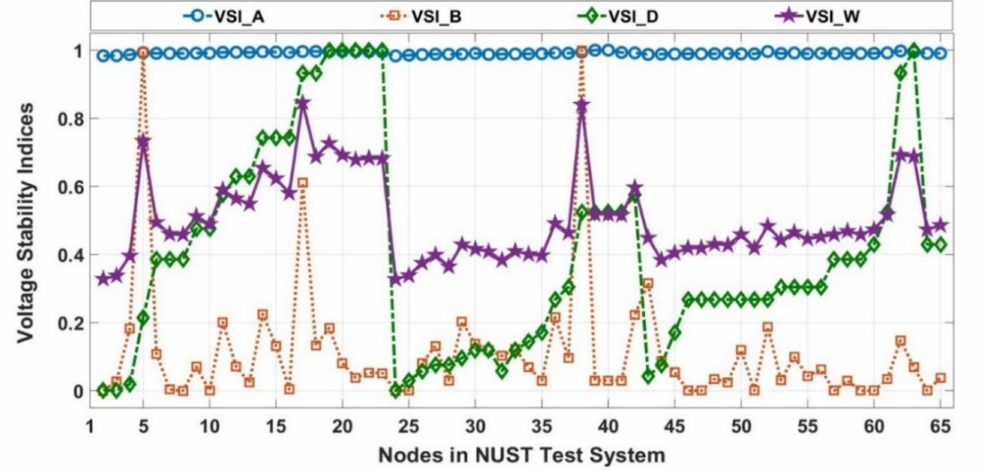
Figure 18. Various VSIs for optimal sitting locations in the 65-bus MCMG under